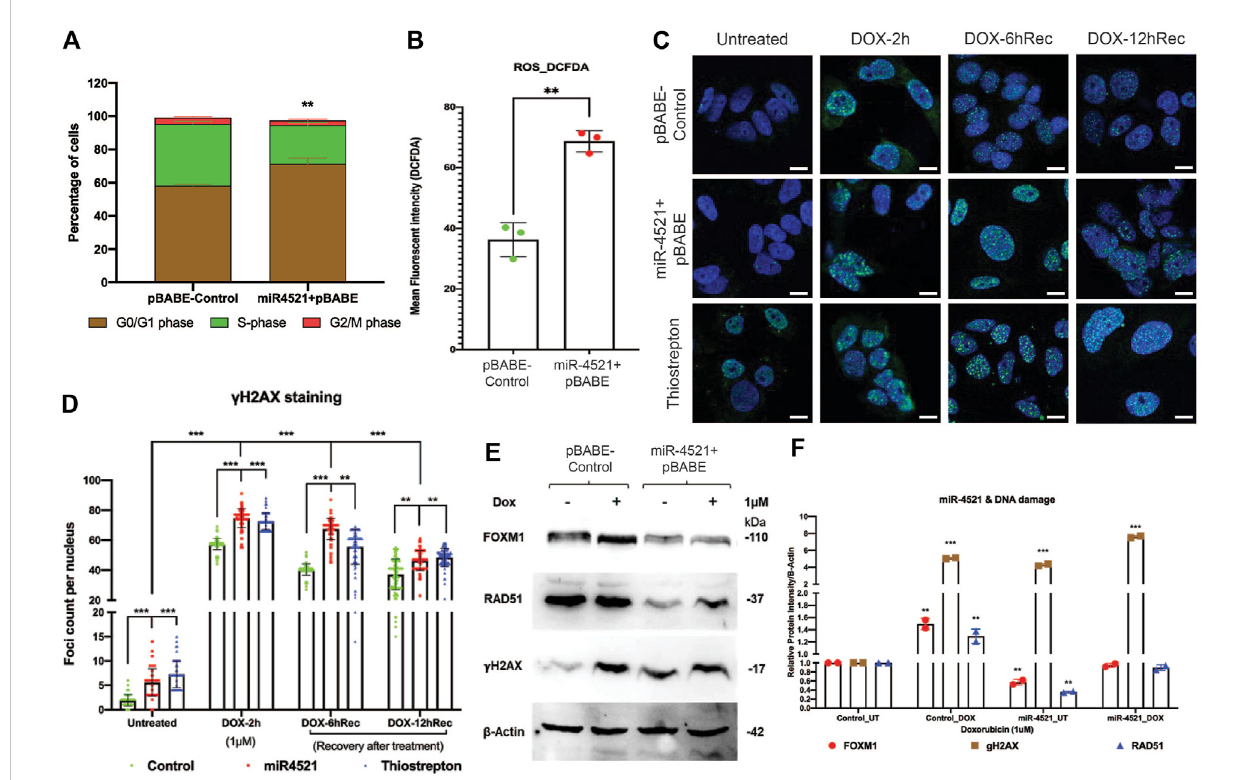
FIGURE 5 miR-4521 expression induces cell cycle arrest, increased ROS level and perturbs DNA damage response in breast cancer (A) Cell cycle analysis of miR-4521overexpressionandcontrolcellsuponsynchronizingthecellsatS-phaseby fl uorescence-activated cellsorting(FACS);pairedStudent ’ s t -test (two-tailed) was performed between control and miR-4521 over expression groups for each cell cycle stages, ** p < 0.001, ( n = 3). miR-4521 overexpression induces cell cycle arrest at G0/G1 phase by inhibiting FOXM1 mediated cell cycle regulation in breast cancer. (B) Fluorescence- activatedcellsorting(FACS)analysisofcellularROSincontrolcellsandmiR-4521overexpressingcellsusing2 ′ ,7 ′ -dichloro fl uorescindiacetate(DCF-DA) as the molecular probe, ** p < 0.001, ( n = 2). Cellular ROS level was increased in miR-4521 overexpressing cells when compared to control cells contributing to cell cycle arrest and DNA damage in breast cancer cells. (C) Immuno fl uorescence analysis of DNA damage response in untreated and upon 1 µM doxorubicin (DOX) treatment for 2 h, followed by recovery for 6 hrs and 12 hrs in plasmid control cells, miR-4521 overexpressing cells, and FOXM1 inhibitorthiostrepton treatedcells, (D) γ H2AX fociwerequanti fi edfrom 100cells per group; two-way ANOVA with TurkeyHSD posthoc testwas performed between control and miR-4521 overexpression groups or control and FOXM1 inhibitor thiostrepton treated groups at different